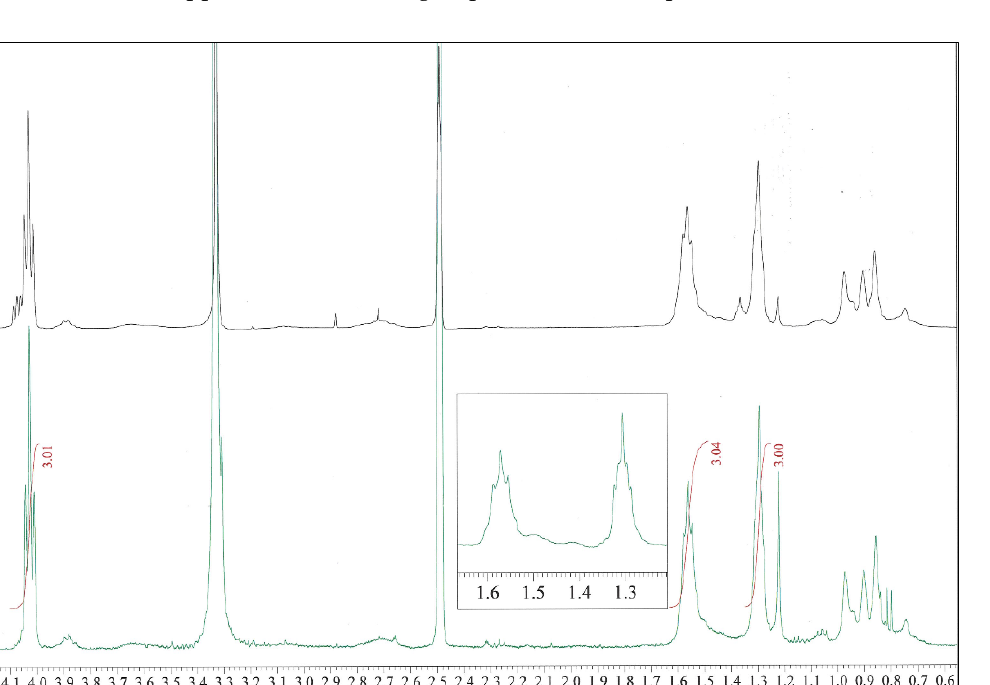
Figure 4. 1 H NMR of ( A ) commercial Larithane after distillation of DMF in a deep vacuum with a better resolution of the multiplets at 1.31 and 1.57 ppm confirmed quintet splitting, and ( B ) the fibrous nanotextile of Larithane after electrospinning. Both of the polymers were dissolved in DMSO- d 6 .